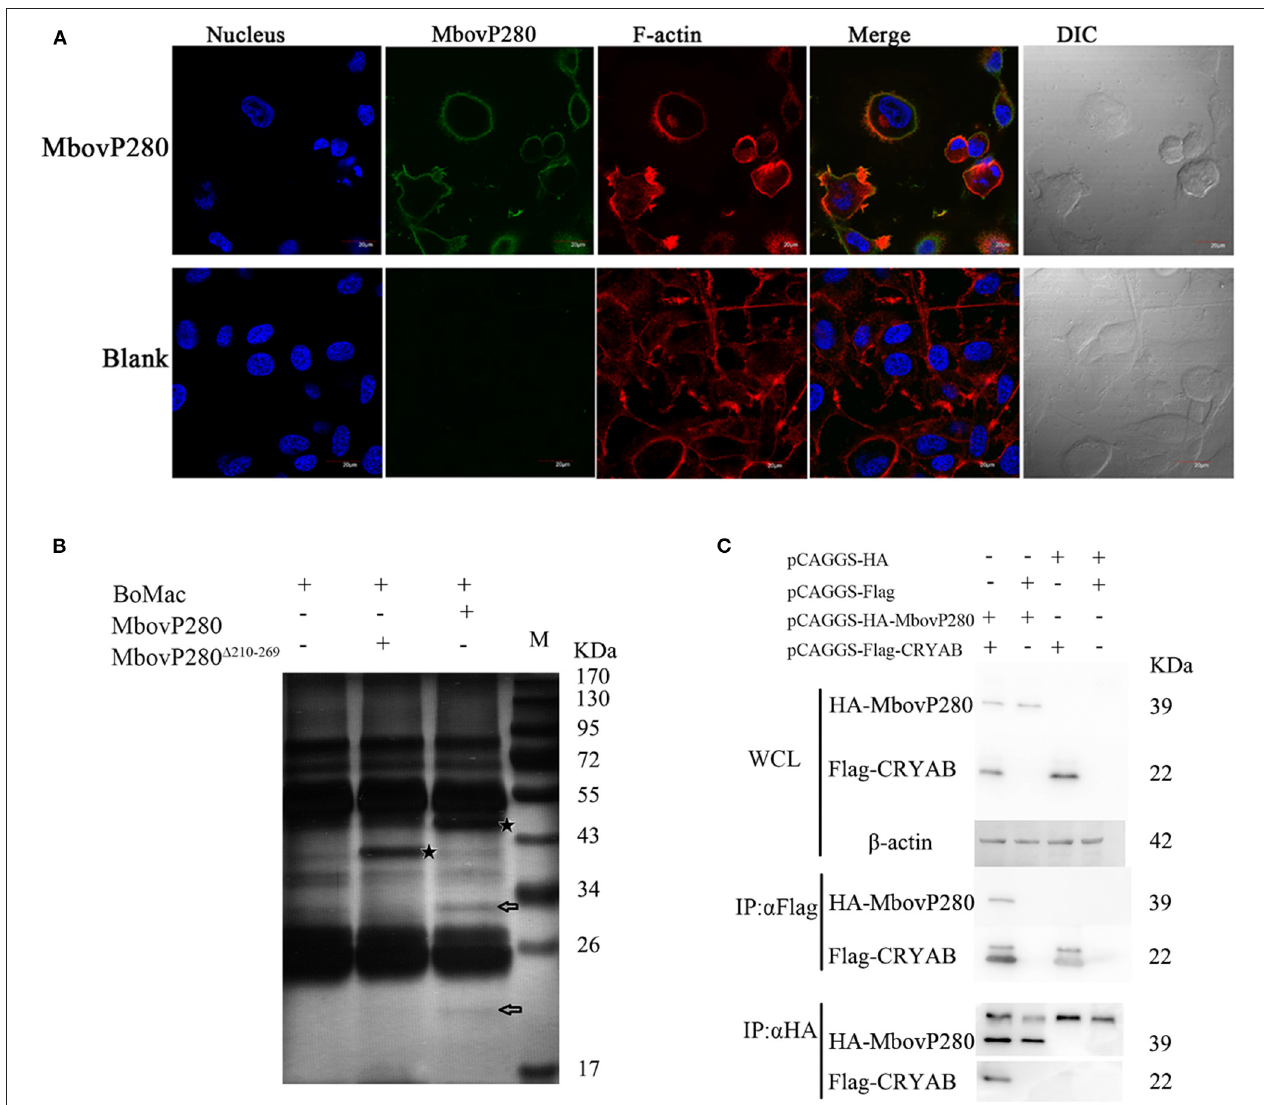
FIGURE 4 | Interaction between MbovP280 and BoMac. (A) Binding assay of MbovP280 to BoMac cells. BoMac cells (1 × 10 5 ) were incubated with 0.5 µ M MbovP280 for 1h at 37 ◦ C. MbovP280 was probed with polyclonal antibody directed against MbovP280 (1:500) and Alexa-Fluor-488-conjugated anti-IgG antibody (1:1,000) (green). Nuclei were stained with DAPI (5 µ g/ml) and actin filaments with rhodamine phalloidin (100nM). (B) Identification of MbovP280-binding ligands with mass spectrometry. BoMac cell lysates were incubated with MbovP280 (10 µ g), MbovP280 1 210 − 269 (10 µ g), or PBS, and immunoprecipitated (IP) with a polyclonal antibody directed against MbovP280 (5 µ g) and agarose bead (50 µ l) labeled with Protein A/G. Arrows indicate specific MbovP280-binding ligands resolved with SDS-PAGE. And the asterisks represent either MbovP280 or MbovP280 1 210 − 269 . (C) Interaction between MbovP280 and CRYAB. At 32h post transfection with plasmids encoding HA, HA–MbovP280, Flag, or Flag–CRYAB, HEK293T cells were harvested and the whole-cell lysates were immunoprecipitated with commercial antibodies directed against either the HA or Flag tag, and Protein A/G agarose beads. MbovP280 and CRYAB were then detected with western blotting assays using the antibodies against either the HA or Flag